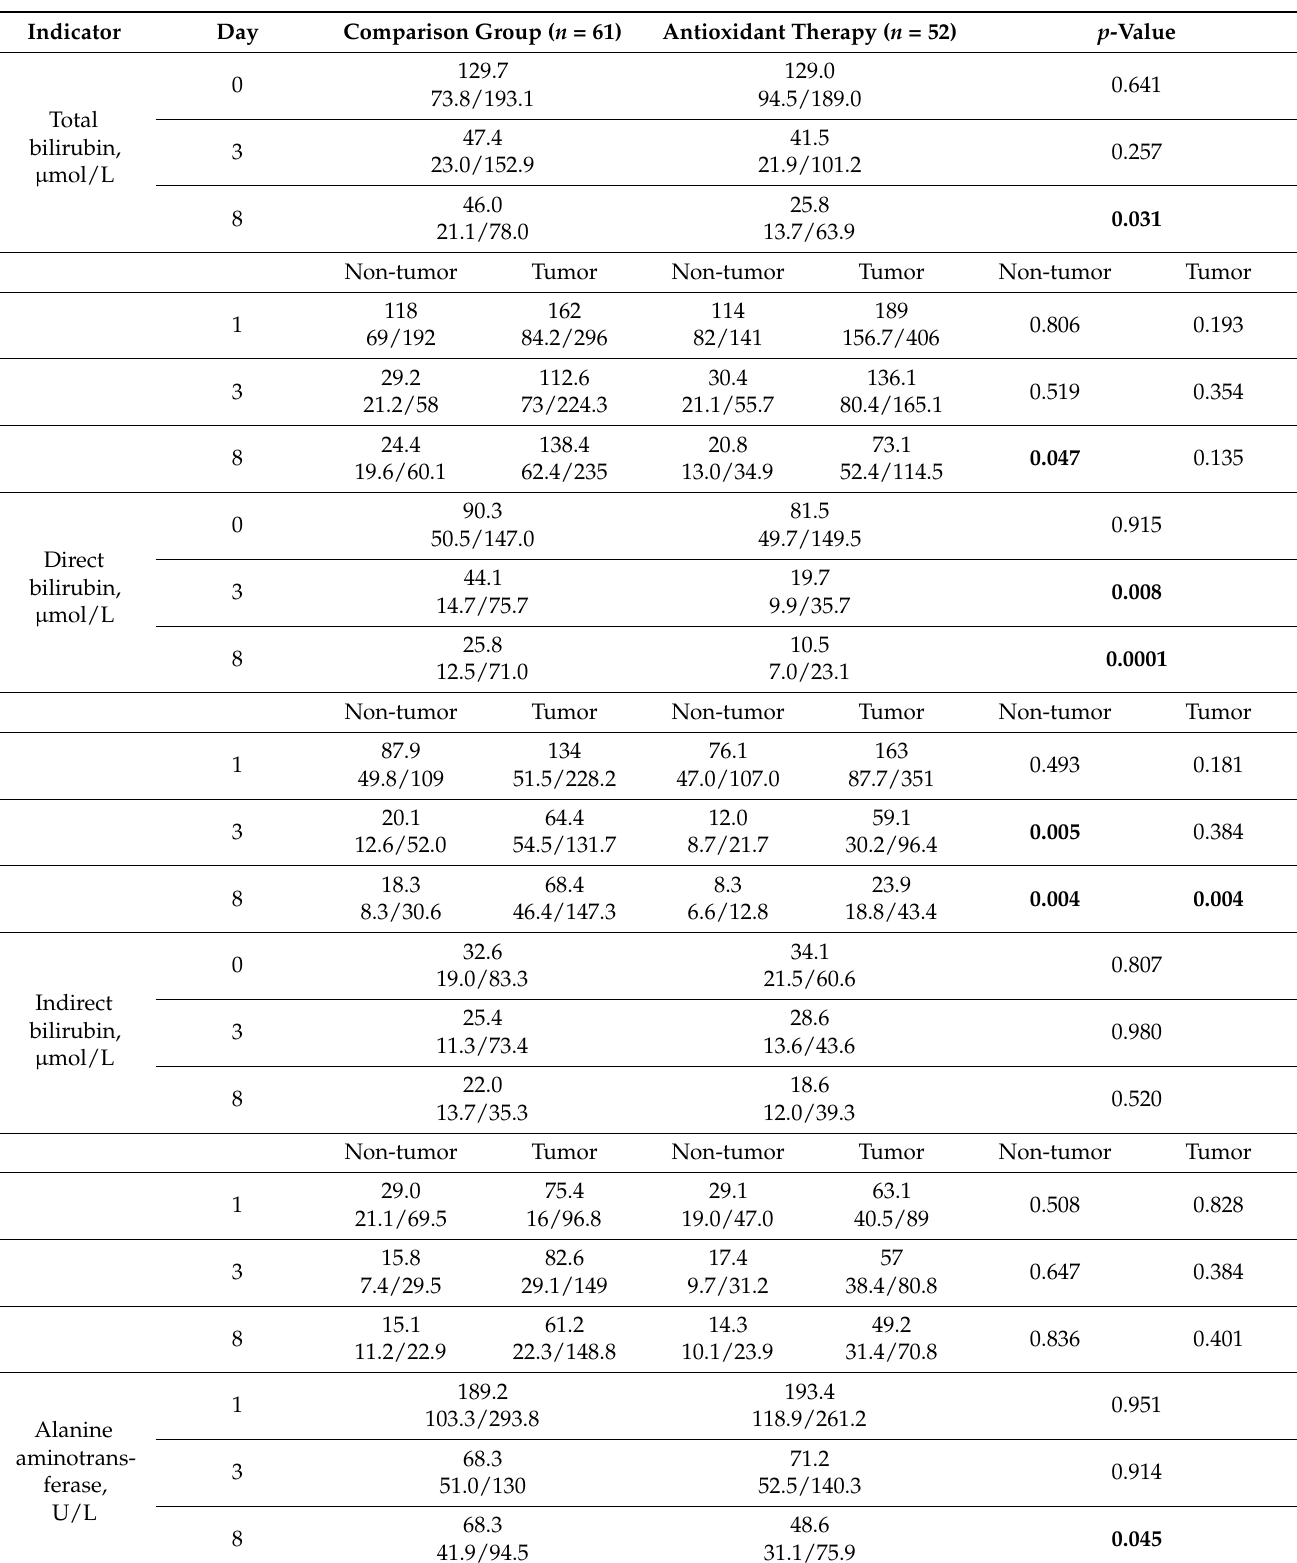
Table 3. Dynamics of biochemical markers of liver function in patients with obstructive jaundice who received and did not receive antioxidant